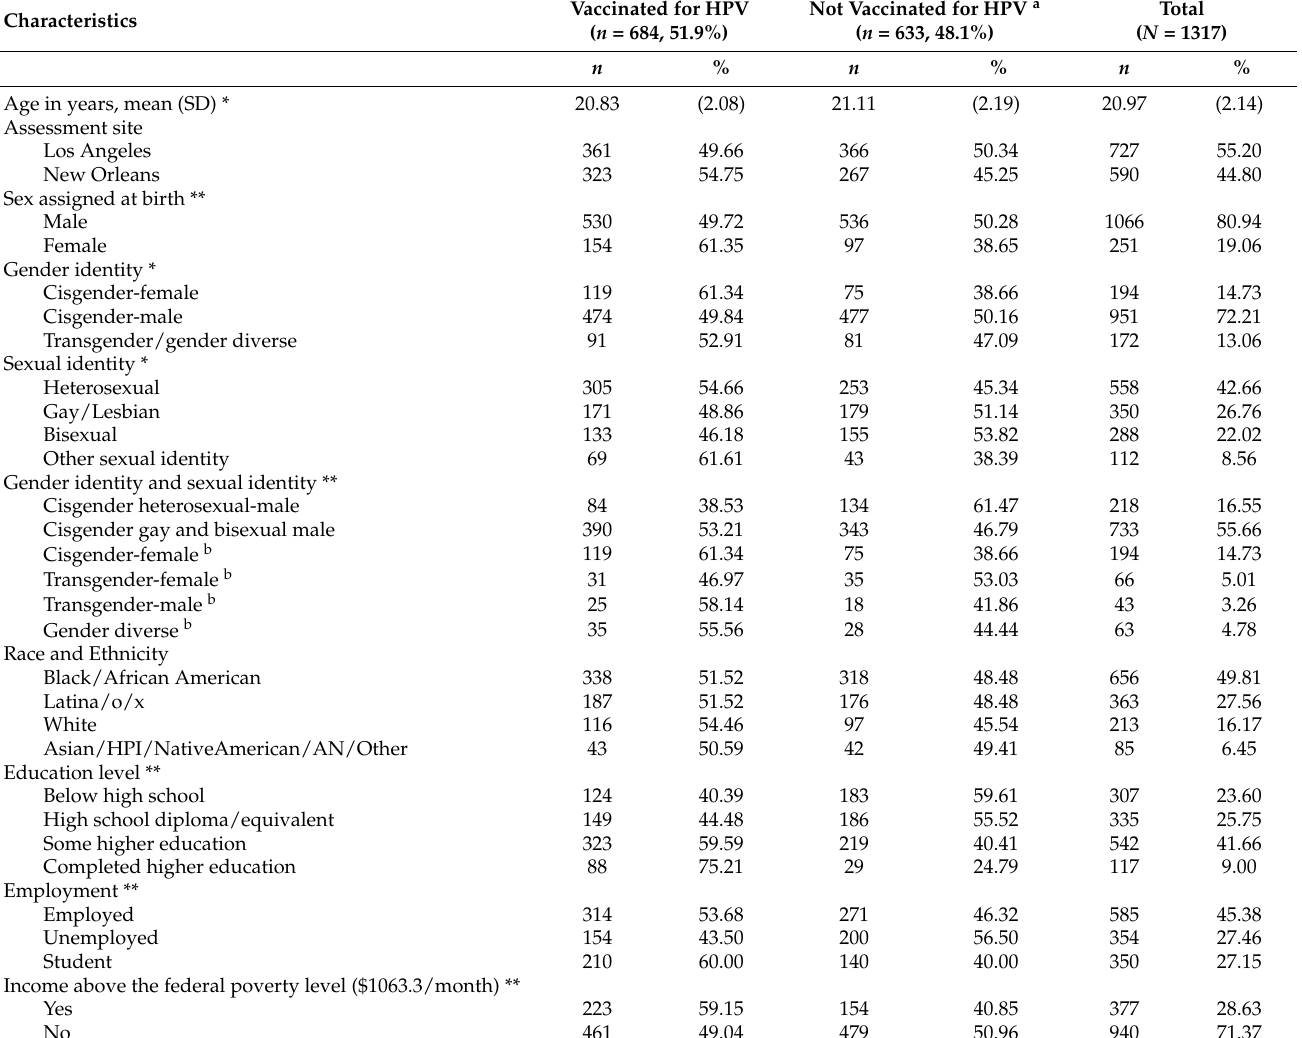
Table 1. Comparison of sociodemographic and other characteristics by HPV vaccination status ( N = 1317).